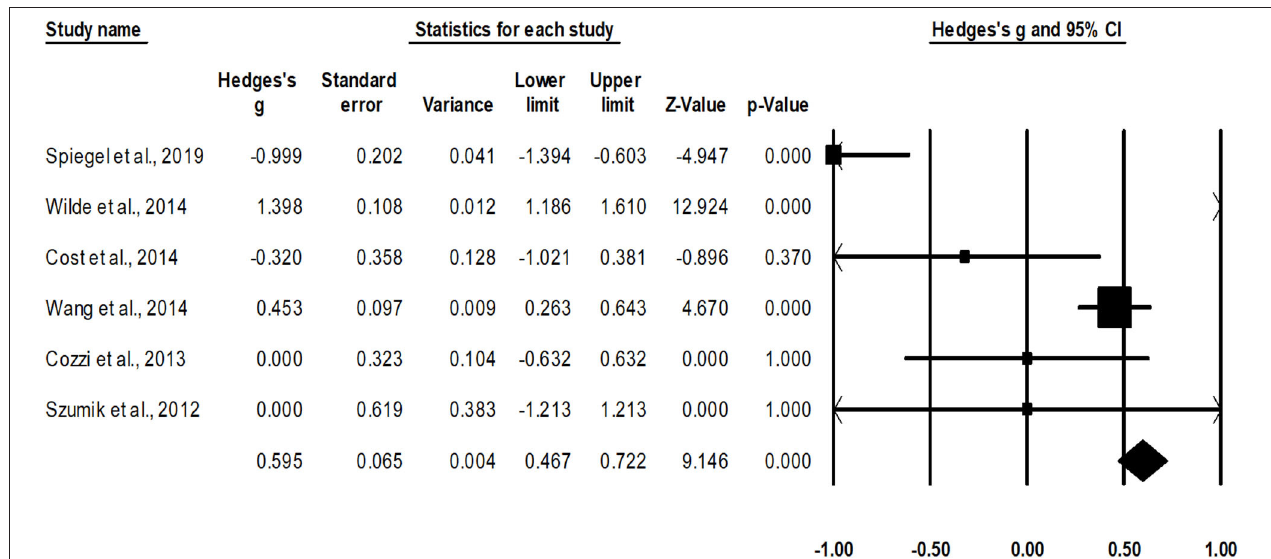
FIGURE 3 | Illustrates the forest plot for studies evaluating the effects of nephron sparing surgery on survival rate in children with unilateral Wilms tumor. Weighted effect size is presented as boxes; 95% CIs are presented as whiskers. They demonstrate survival rate (%) in between cases operated with radical nephrectomy and nephron sparing surgery. A negative effect represents enhanced survival for radical nephrectomy; a positive effect represents enhanced survival for nephron sparing surgery.